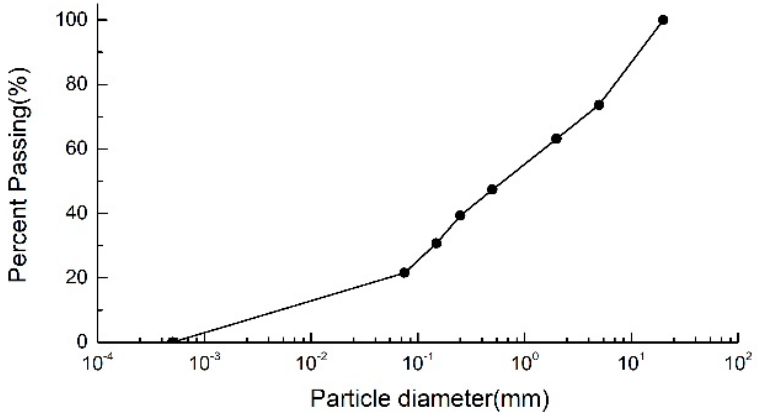
Figure 1. Grain − size distribution curve of calcareous sand layer.